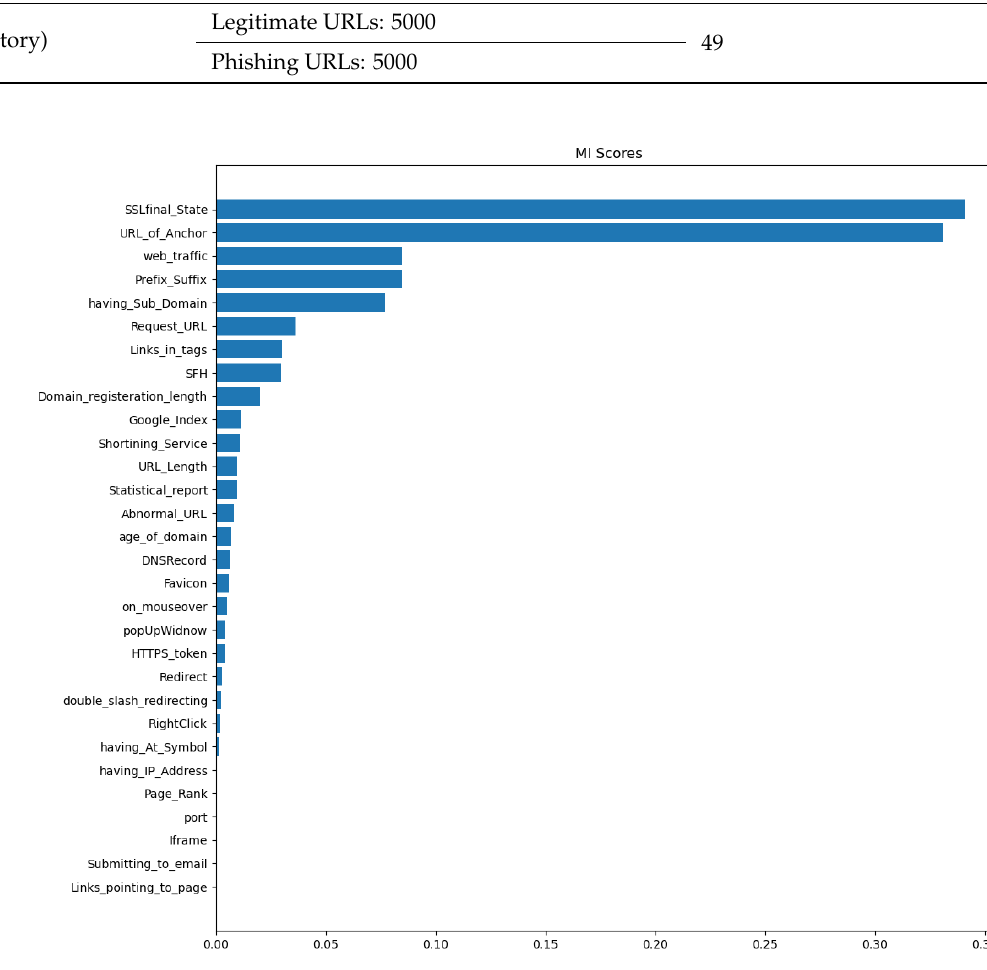
Figure 6. Mutual information gain score for Dataset-1.